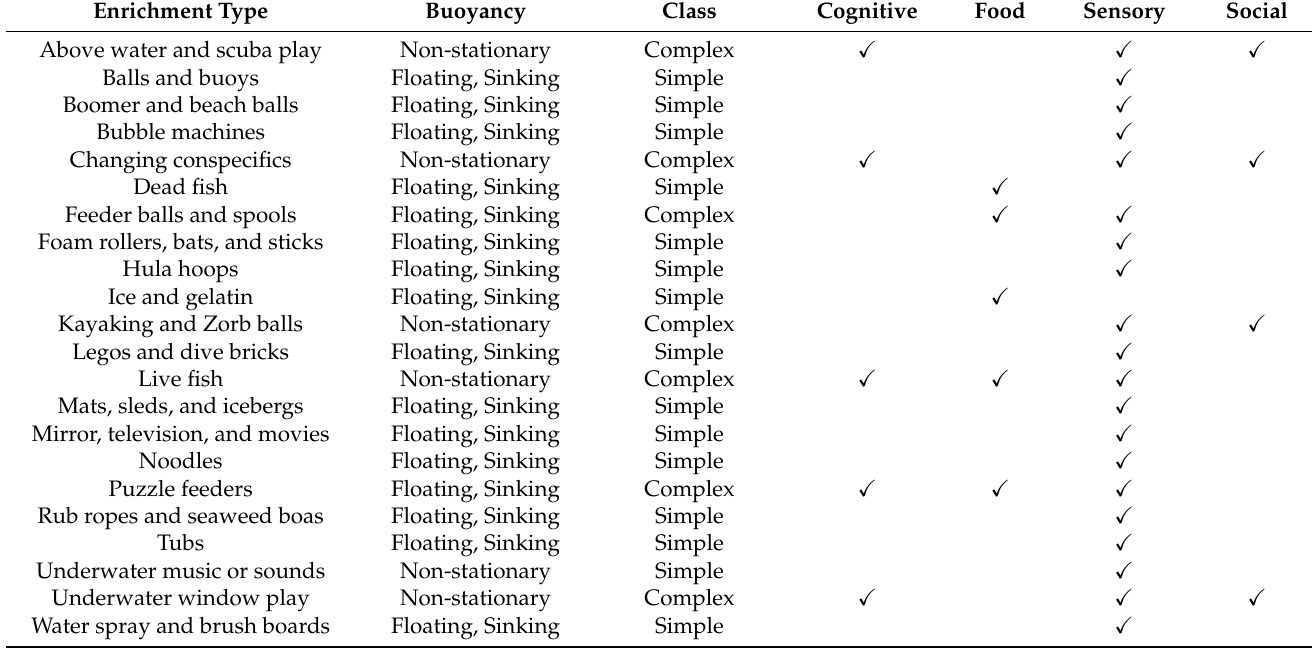
Table 1. Classification of enrichment as simple or complex based on its categorization as cognitive, food, sensory, and/or social